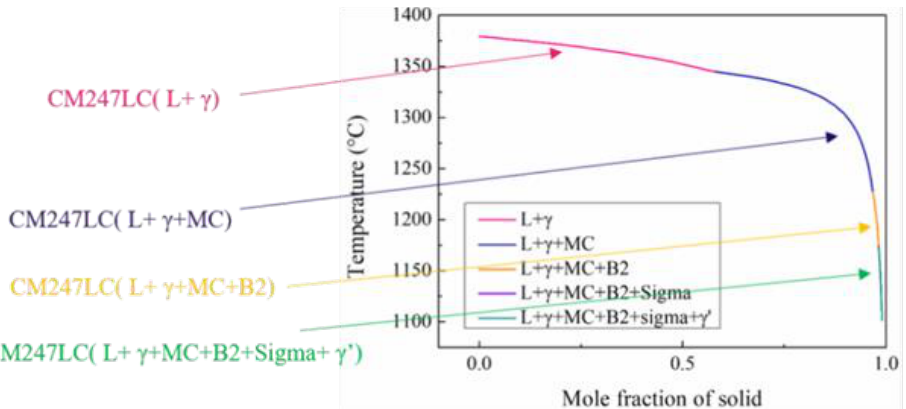
Figure 2. Temperature vs. molar fraction of a solid during the solidification sequence from high to low temperatures for the CM247LC alloy.